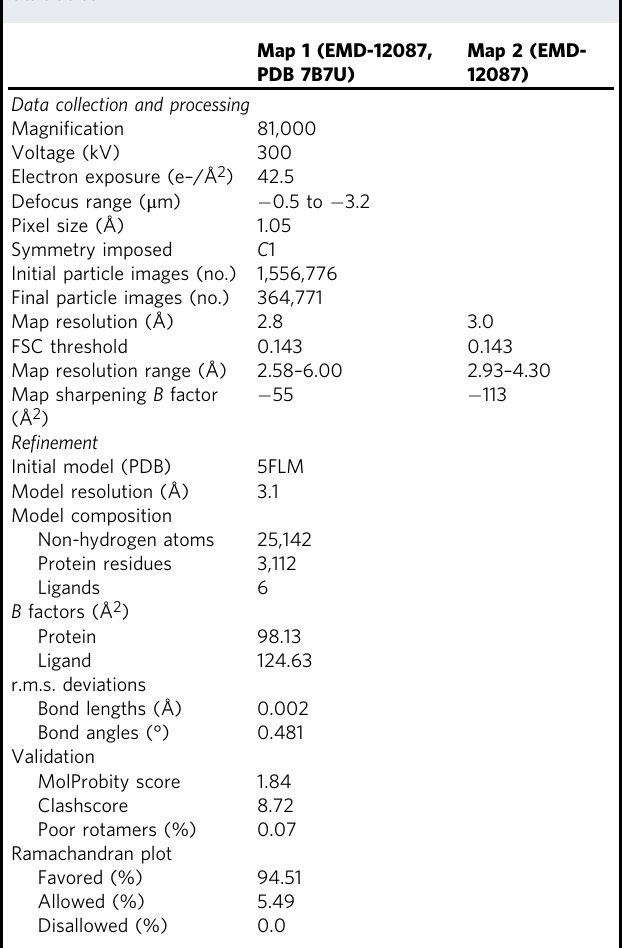
Table 1 Cryo-EM data collection, re fi nement and